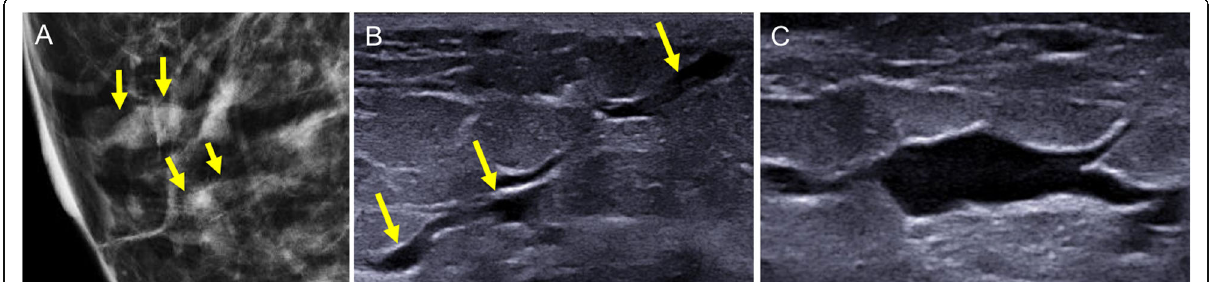
Fig. 18 Ductal ectasia. Different examples of ductal ectasia without interior contents seen on mammography ( a ) and ultrasound ( b, c